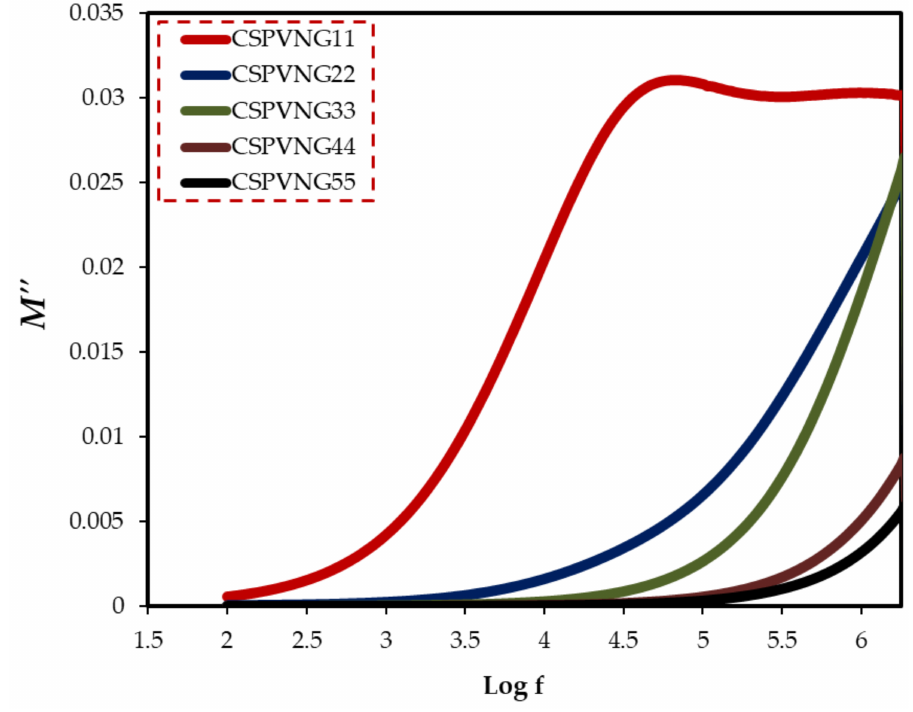
Figure 13. The imaginary part of the electric modulus versus log (f) for all electrolyte samples. The use of Argand (M (cid:48)(cid:48) vs. M (cid:48) ) plots to decide whether a relaxation dynamic